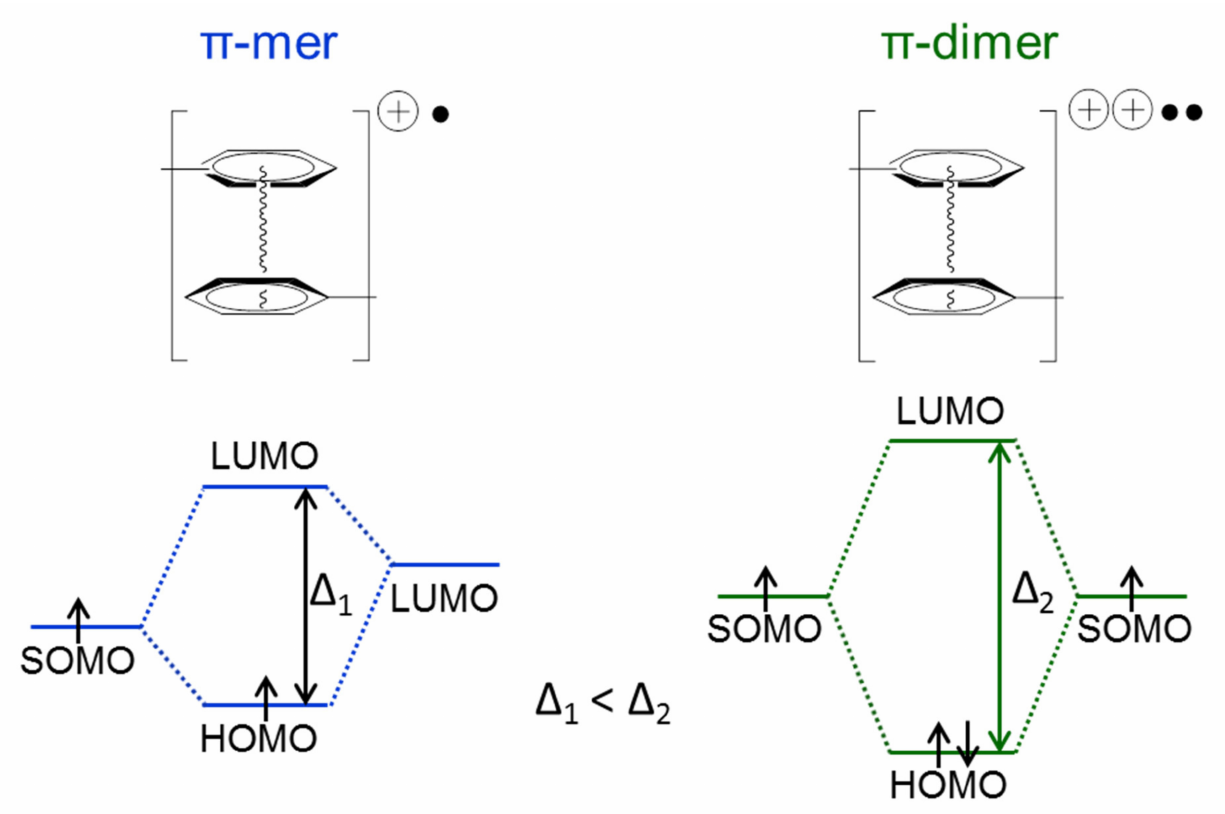
Scheme 3. Schematic drawing of π -dimerization in a general case. Perturbation diagrams showing mixing of SOMO and LUMO to form new orbitals of π -mer (blue) and π -dimer (green). Black arrows indicate the spin of an electron in the corresponding orbital. The delta value characterizes the difference in energy between HOMO and